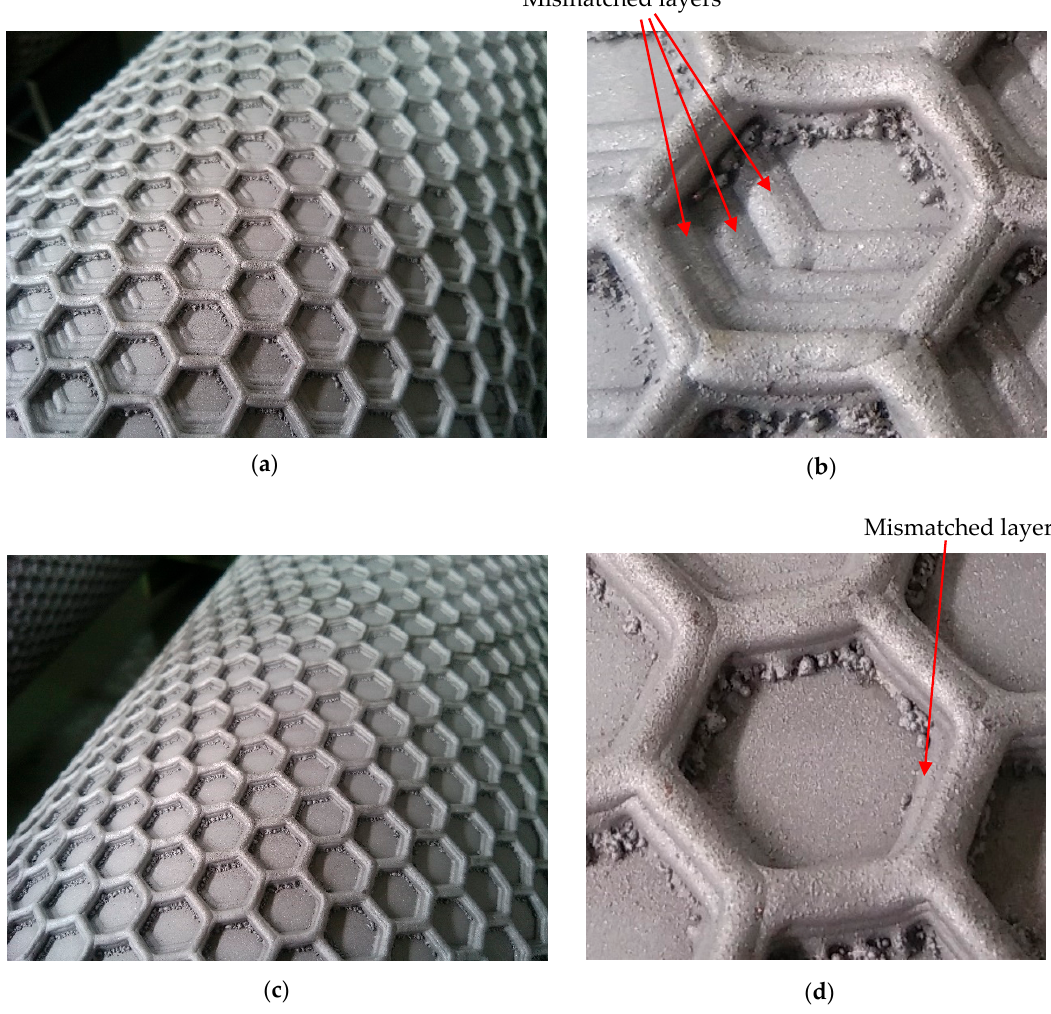
Figure 11. Honeycomb patterns printed by the layer-priority method. ( a ) Full view and ( b ) enlarged view. Honeycomb patterns printed by the section-priority method. ( c ) Full view and ( d ) enlarged view.